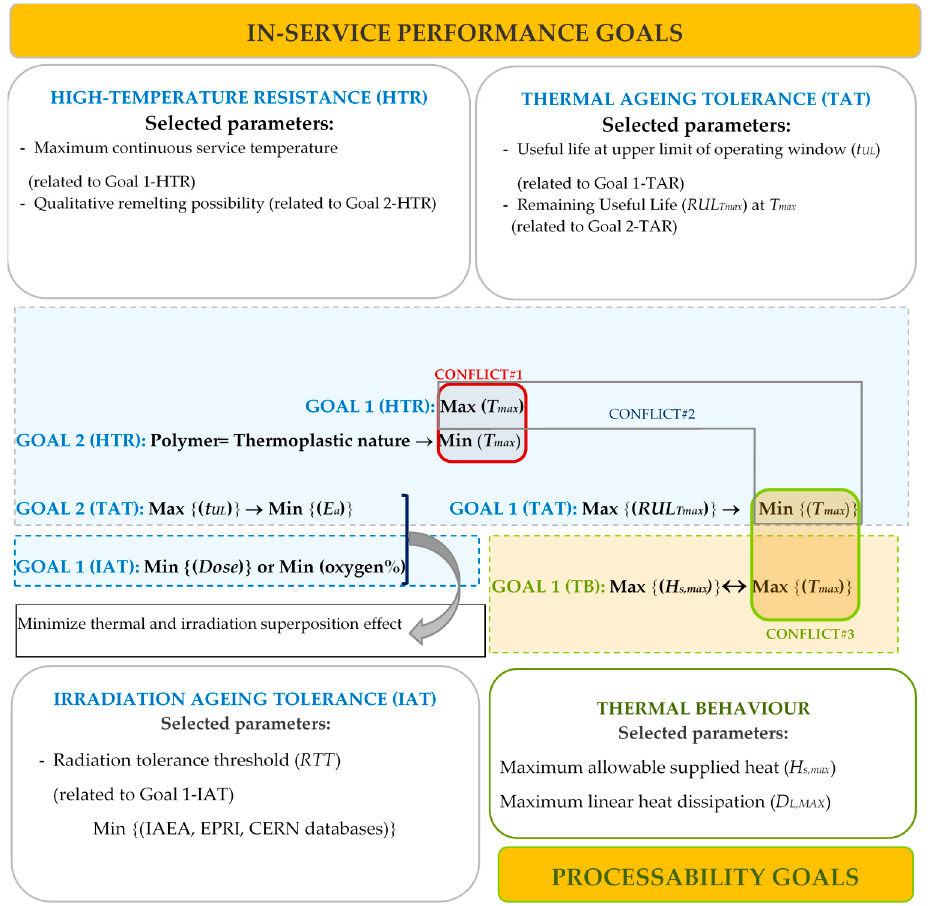
Figure 2. Multiobjective perspective to evaluate goals and conflicts between in-service performance and processability. Abbreviation in Figure: T max : Maximum continuous service temperature; t UL : Useful life at upper limit of operating window; RUL Tmax : Remaining Useful Life at T max ; Ri : Radiation tolerance threshold; E a : Activation energy; H s,max : Maximum allowable supplied heat; D L,MAX : Maximum linear heat dissipation; a : Thermal diffusivity.